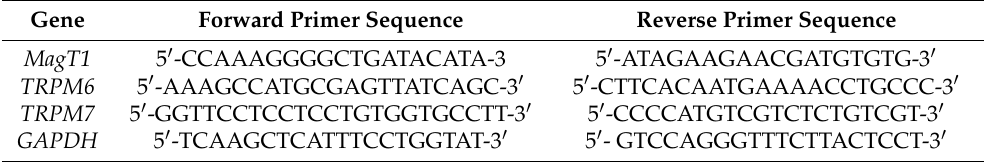
Table 1. Sequences of the primers used for